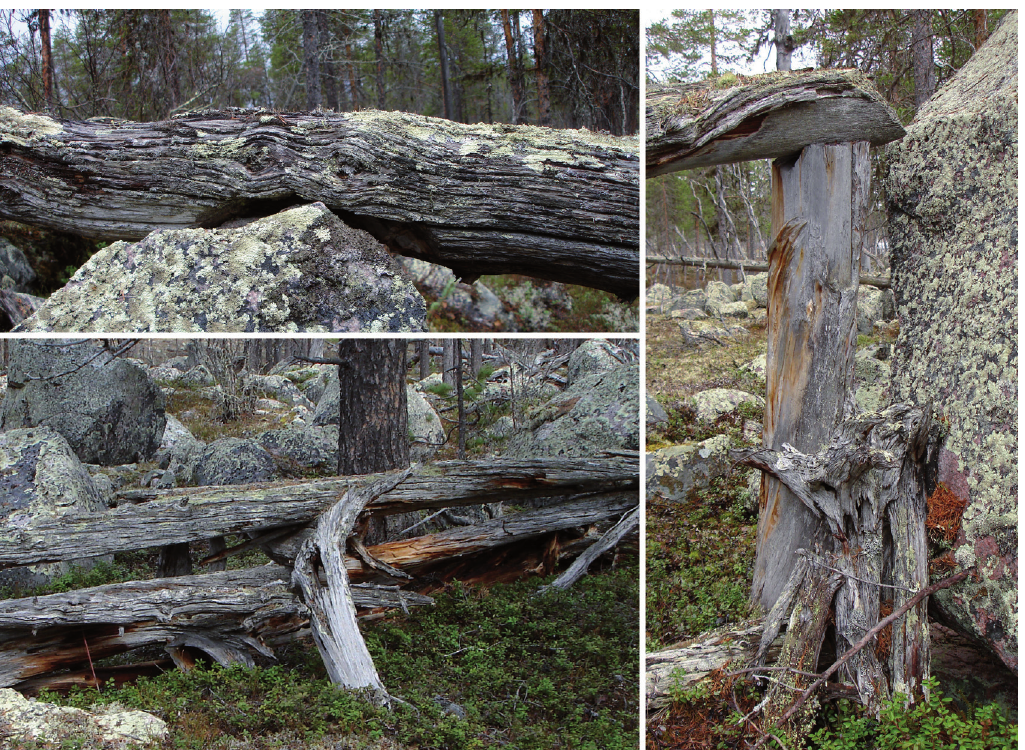
Figure 5. Fence construction details. Upper left, a support consisting of a boulder. The trunk has been notched with an axe. Lower left, a support made from the top part of a pine tree with a suitable branch. In this case, the support also functioned as a lateral stabilizer. To the right, the highest fence part, measuring in total 1.5 m. The stump has been cut in the middle of a scar from an old bark-peeling, a very common cultural remain in the forests of Tjieggelvas, where pine bark formerly was an important staple food for the Sami. Next to the stump, the pine roots turned upside down once served as support for the trunk that now lies on the